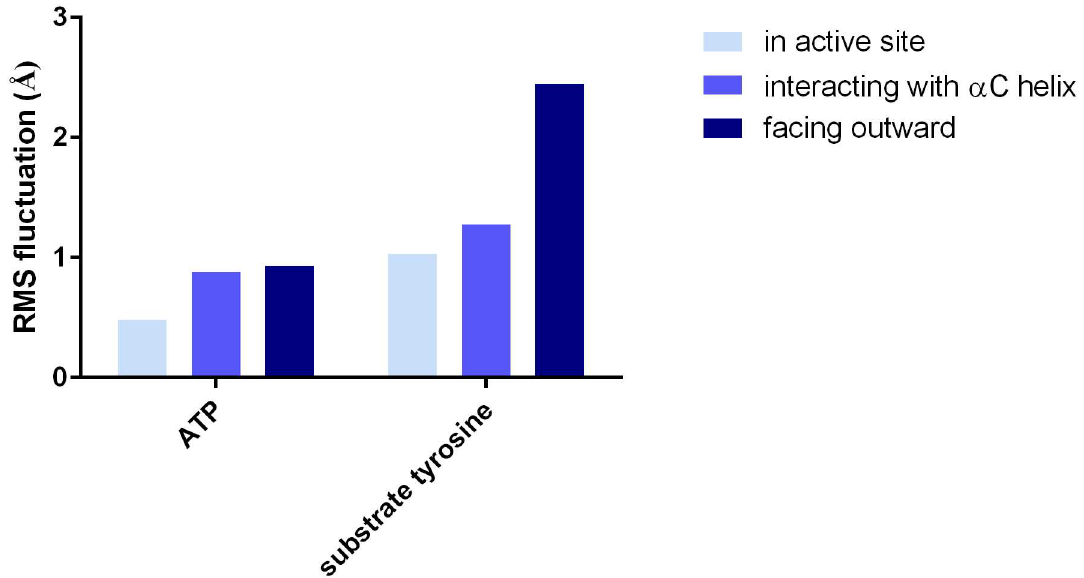
Fig 6. The effect of Arg664 on the precatalytic structure. Root-mean-squarefluctuations of ATP and substrate tyrosine in simulations in which Arg664 was kept in the active site, away from the active site and pointingoutward, or interacting with the α C